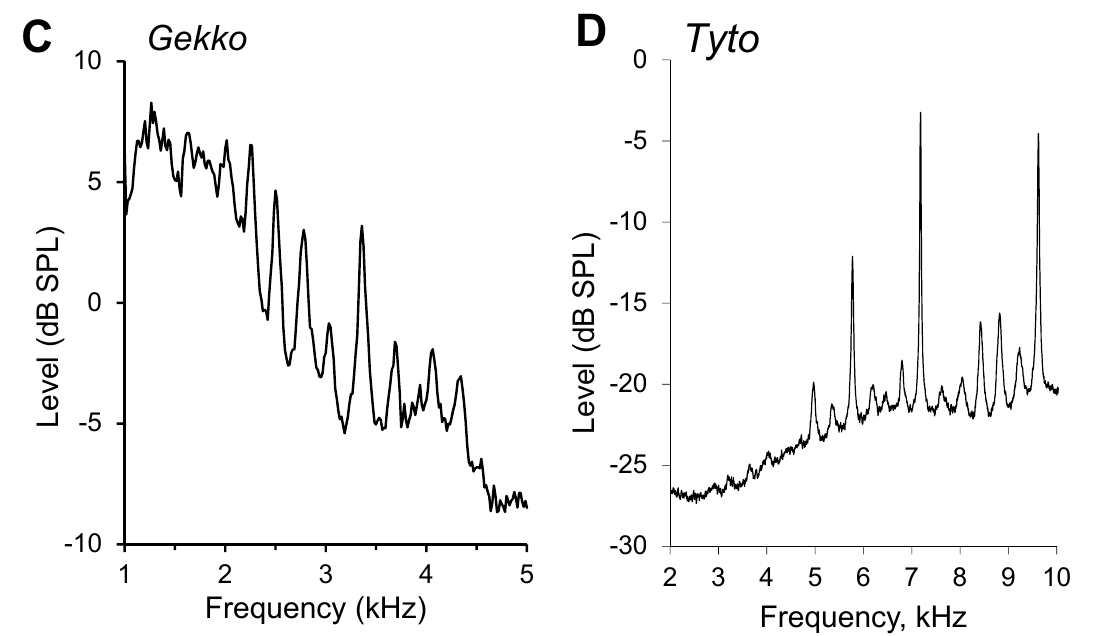
Figure 1. Averaged spectra of spontaneous otoacoustic emissions in ( A ) a frog, Hyla cinerea [19]; ( B ) the monitor lizard, Varanus exanthematicus (with a continuous tectorial membrane) [23]; ( C ) the gecko Gekko gecko (with tectorial sallets) [24]; ( D ) the barn owl Tyto alba [25,26]. Note the differences in scaling of the frequency and level axes.